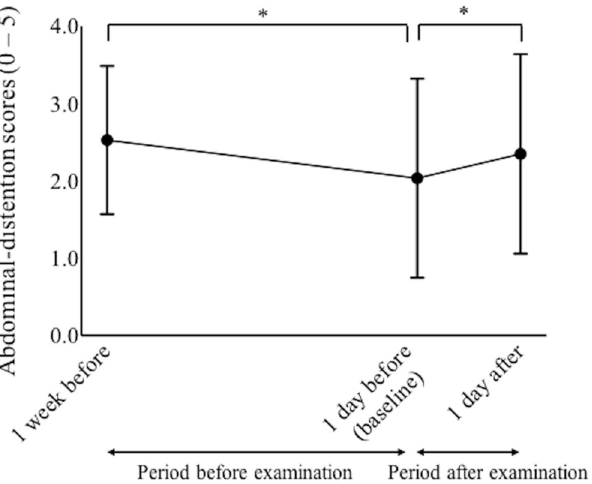
Fig 1. The scores of abdominal distention from 1 week before examination to 1 day after screening for retinopathy of prematurity. Low scores of abdominal distention represent less abdominal distention. � Statistical difference (p < 0.05, paired-t tests with Bonferroni correction).